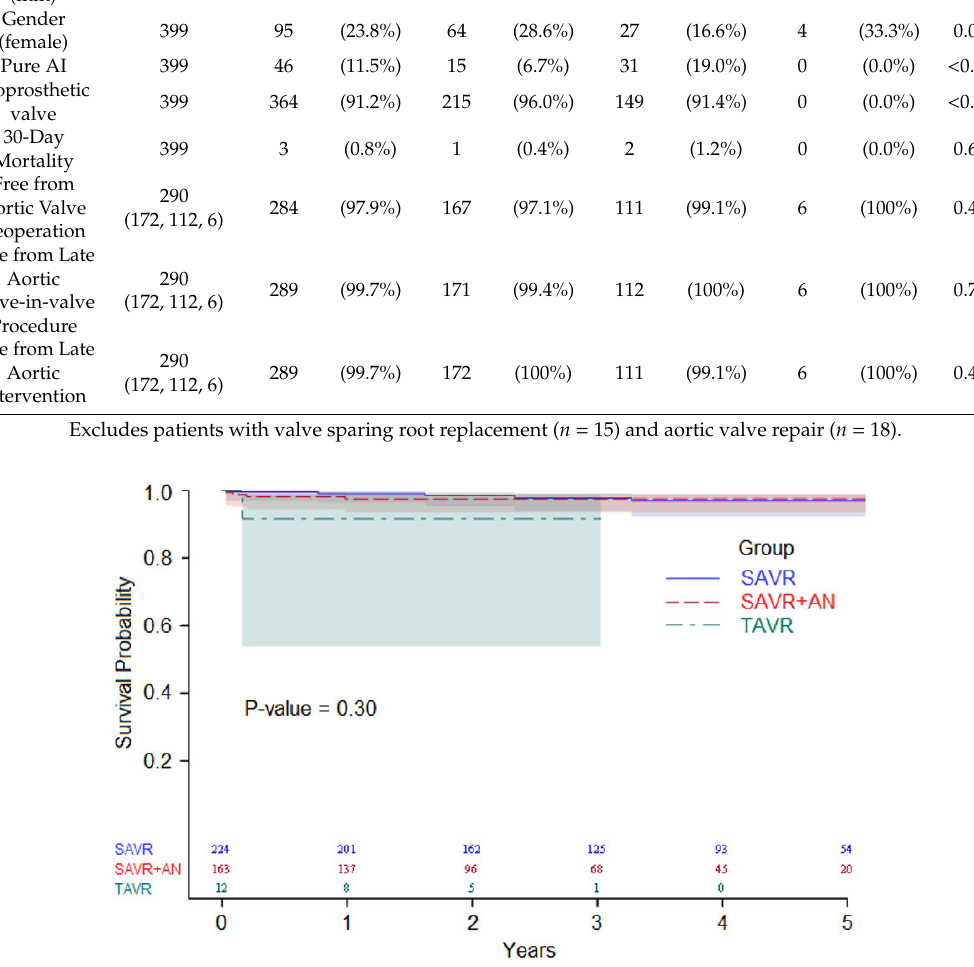
Figure 1. Overall survival estimates in the surgical or transcatheter interventions